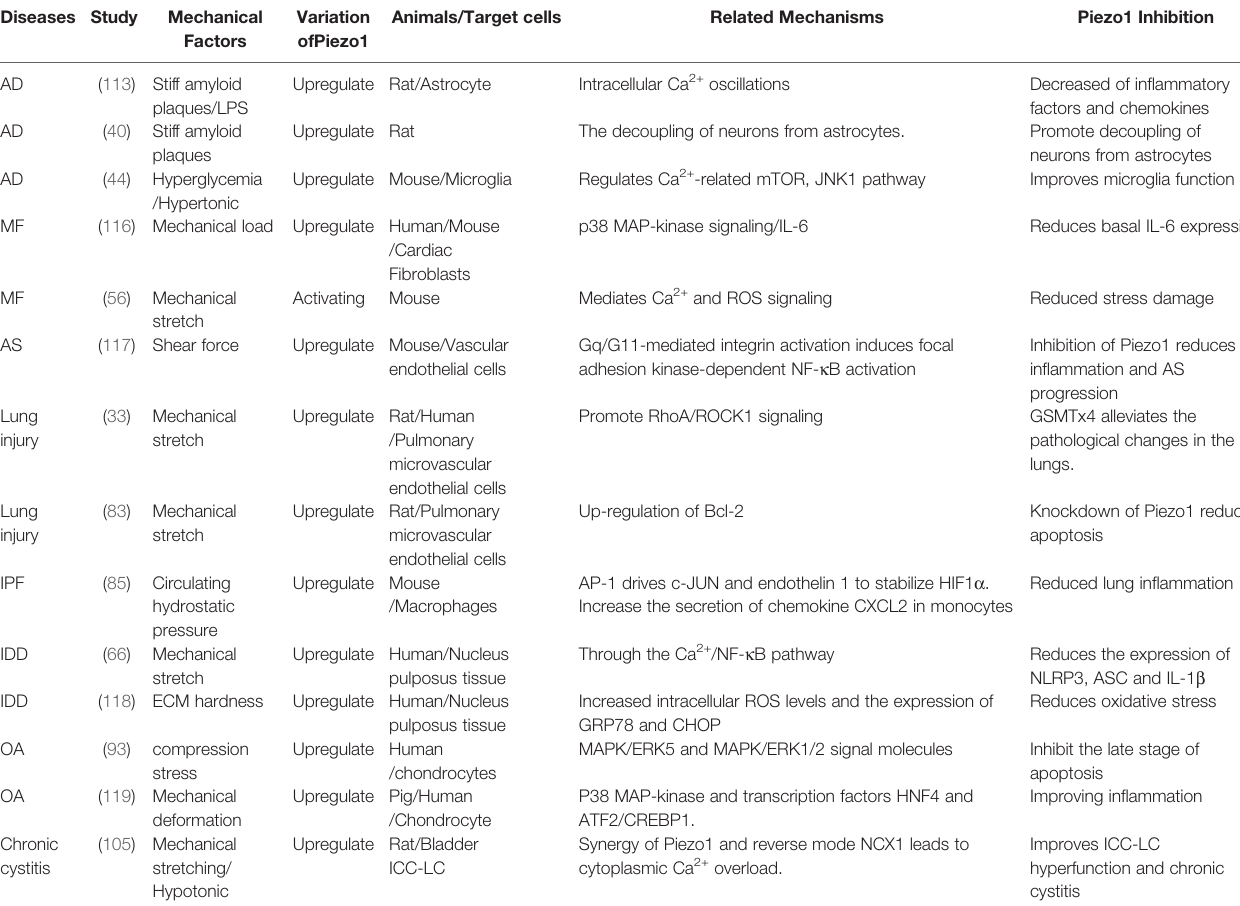
TABLE 1 | Current mechanisms are linking Piezo1 to the development and progression of chronic in fl ammatory